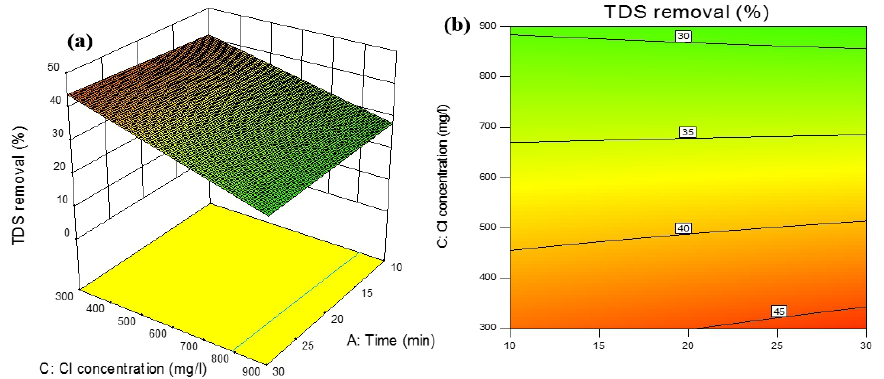
Fig. 7. Effects of Cl − ion initial concentration and process runtime on TDS removal rate (%); a) 3-D plots, b) 2-D contour plots